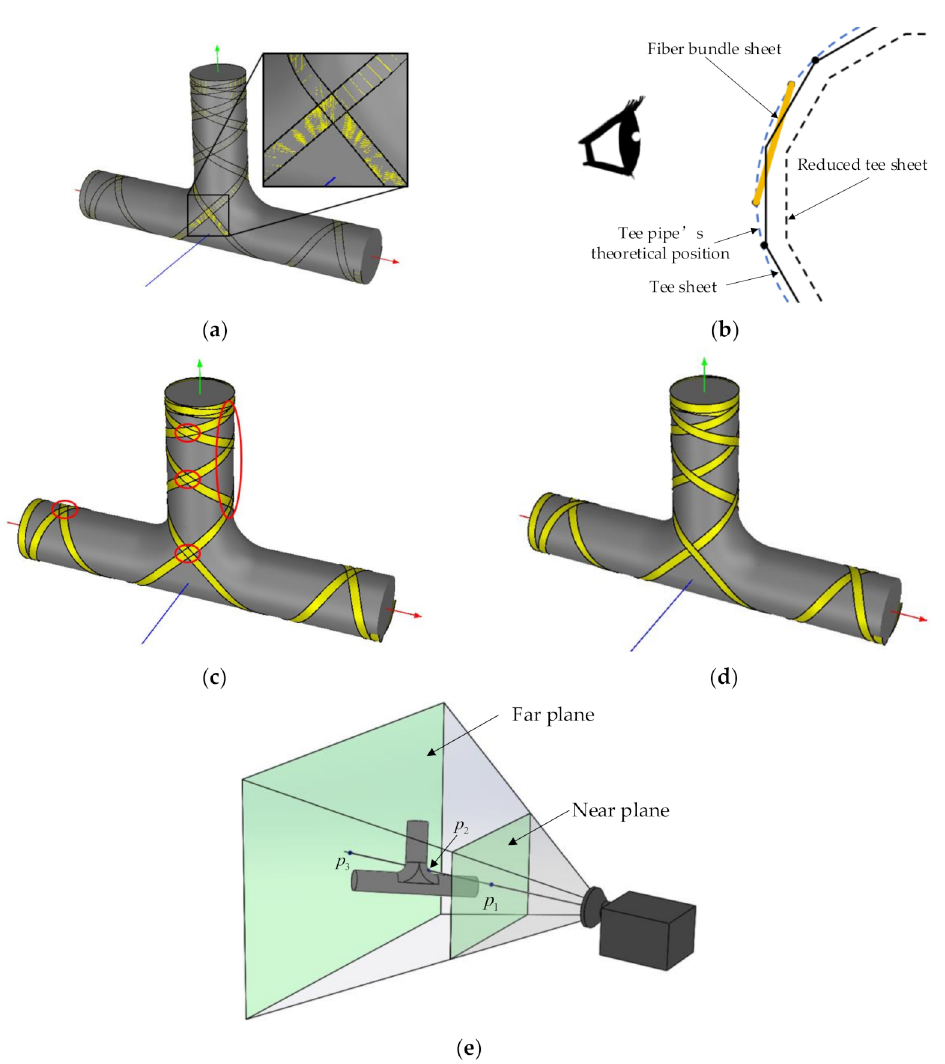
Figure 12. Fiber display and perspective model ( a ) Overlap among sheets; ( b ) Schematic of intersection; ( c ) Writable depth buffer; ( d ) Depth buffer read-only; ( e ) Perspective